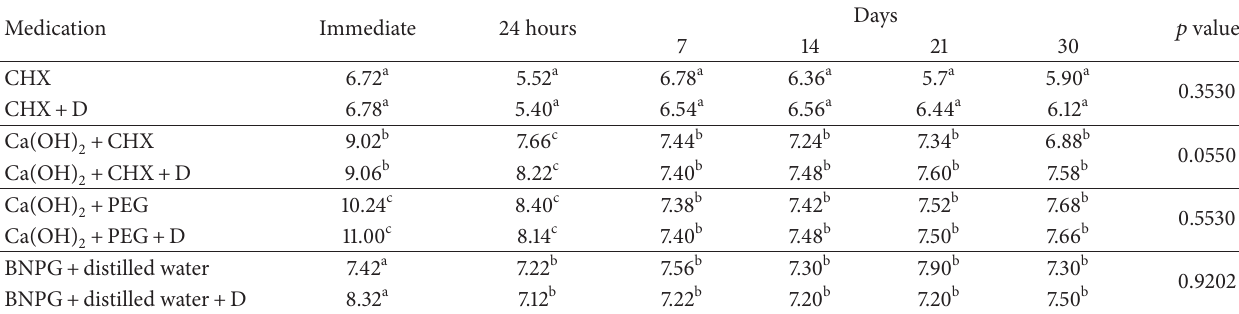
Table 1: Mean pH values of the medications for the six time periods of the study.